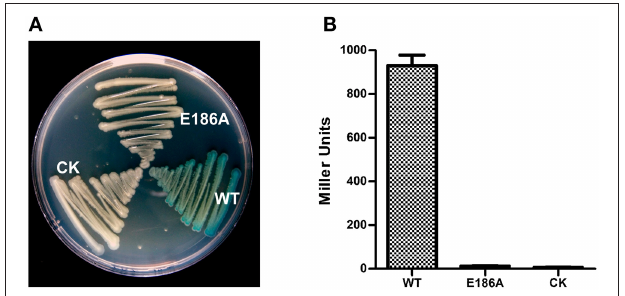
FIGURE 4 | The active site for enzyme activity of the XC1214 protein. Mutation of the active site (E186) of XC1214 resulted in loss of β -galactosidase activity both on plates (A) and in liquid media (B) . Triplicate experiments were performed, and the means ± SD s were calculated.